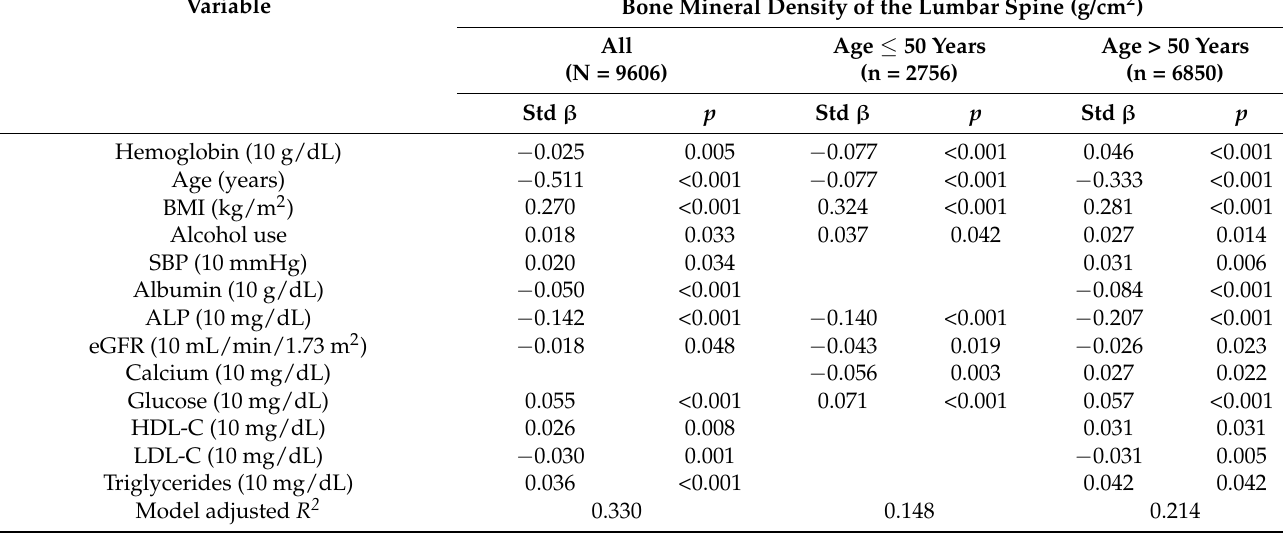
Table 6. Multiple linear regression analysis of factors associated with bone mineral density of the lumbar spine in female patients with and without stratification by age